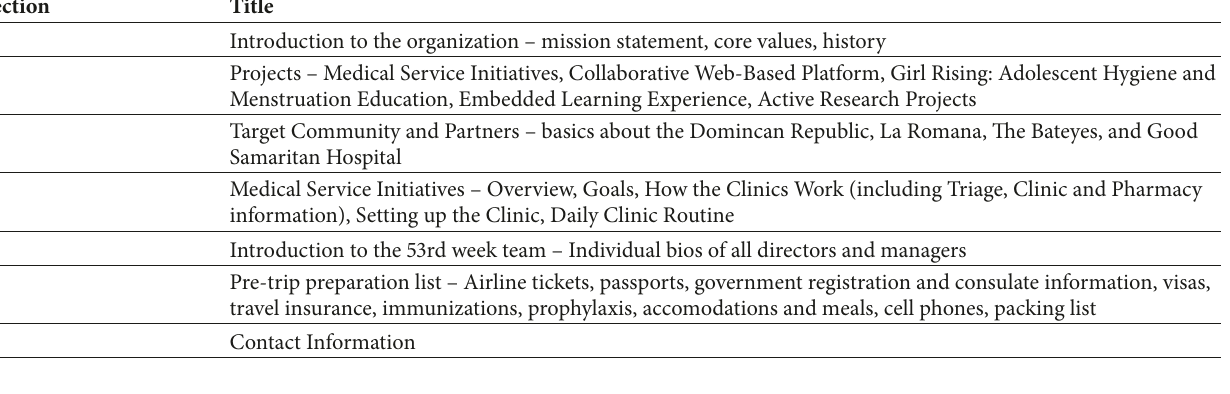
Table 1: Predeparture manual outline.